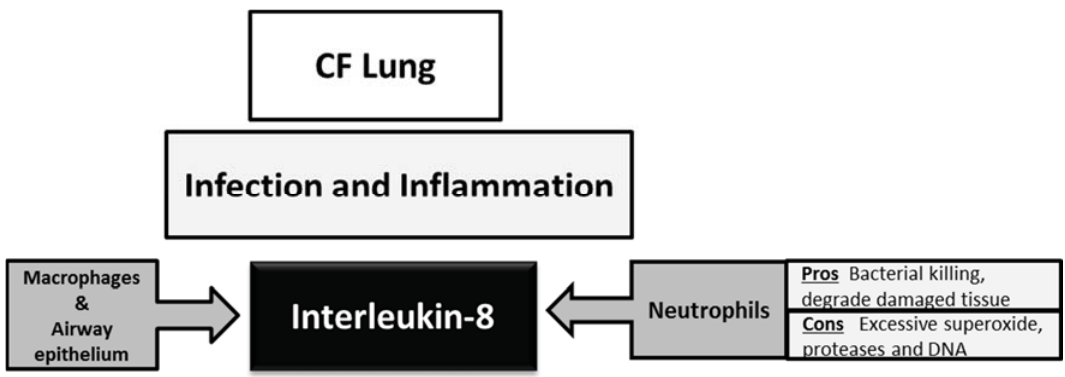
Figure 2. Effects of Interleukin-8 in the cystic fibrosis